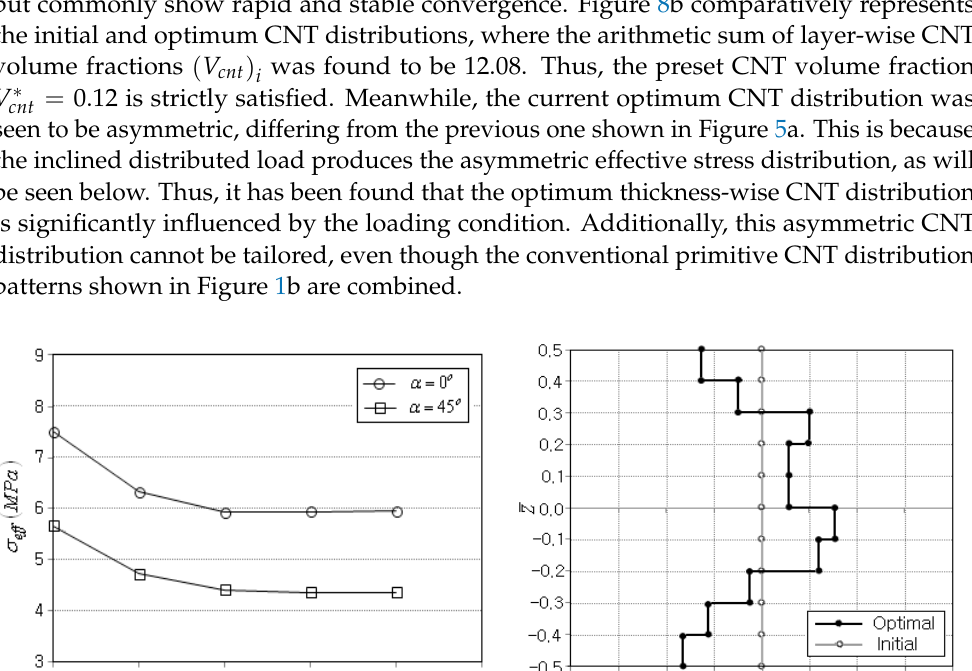
( b ) Figure 9. Comparison of thickness-wise stress distributions ( o 45 =α ): ( a ) the axial stress, ( b ) the effective stress.